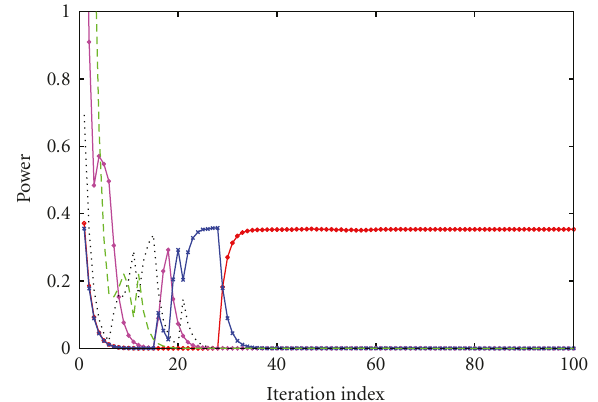
Figure 7: Illustration of P l ( i ) ( k ) of the DCLS algorithm with K = 5 for the quasiregular network of 200 links versus the iteration index i , for an arbitrary l and all k = 1,2,3,4,5, where λ = 32 and ξ = 0 . 5. At convergence, only one of P l ( i ) ( k ) for k = 1,2,3,4,5 is nonzero.